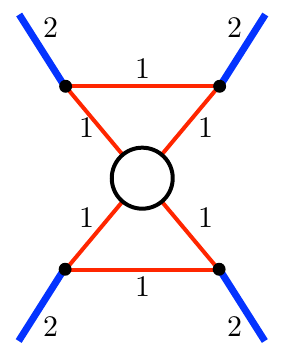
p 2 m 22 22 if m 2 > 1 . !